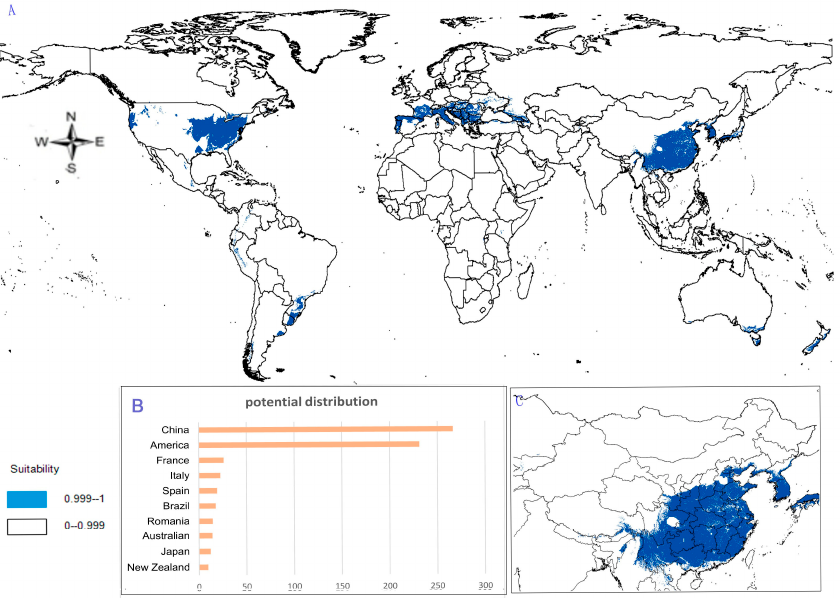
Figure 3. Spatial distribution map of potential suitable distribution for P. japonicus by GMPGIS . ( A ) Global potential distribution; ( B ) Global rank of the potential distribution area; ( C ) Chinese potential distribution. (2)